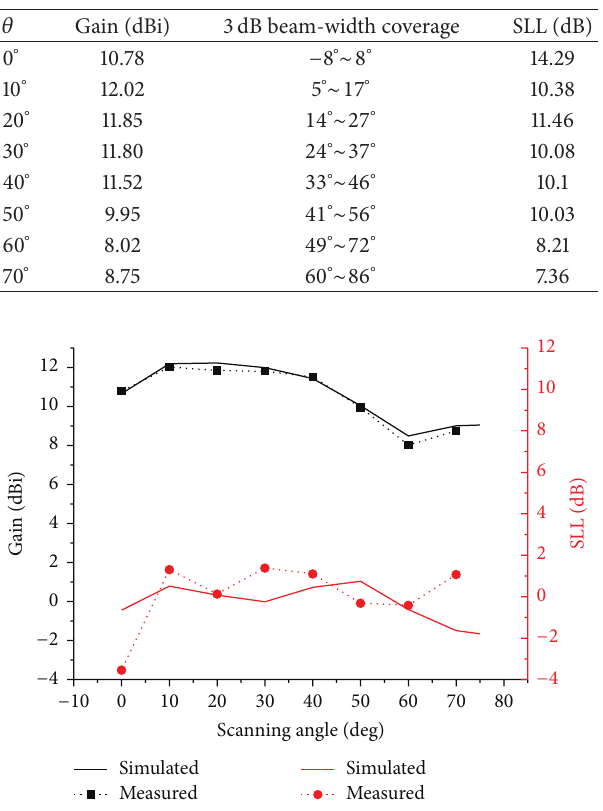
Figure 8: Maximum gain and SLL when the array scans its main beam from 0 ∘ to 70 ∘